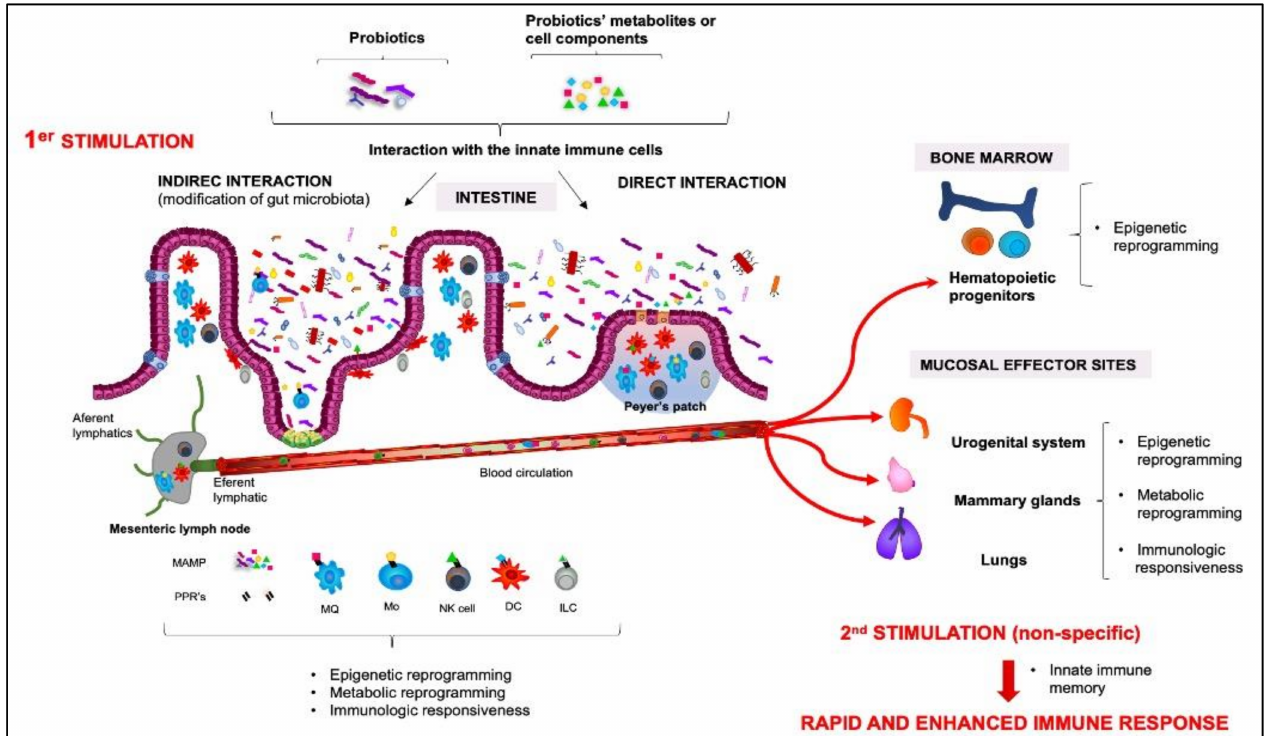
Figure 6. Representative model of the innate immune memory response stimulated by